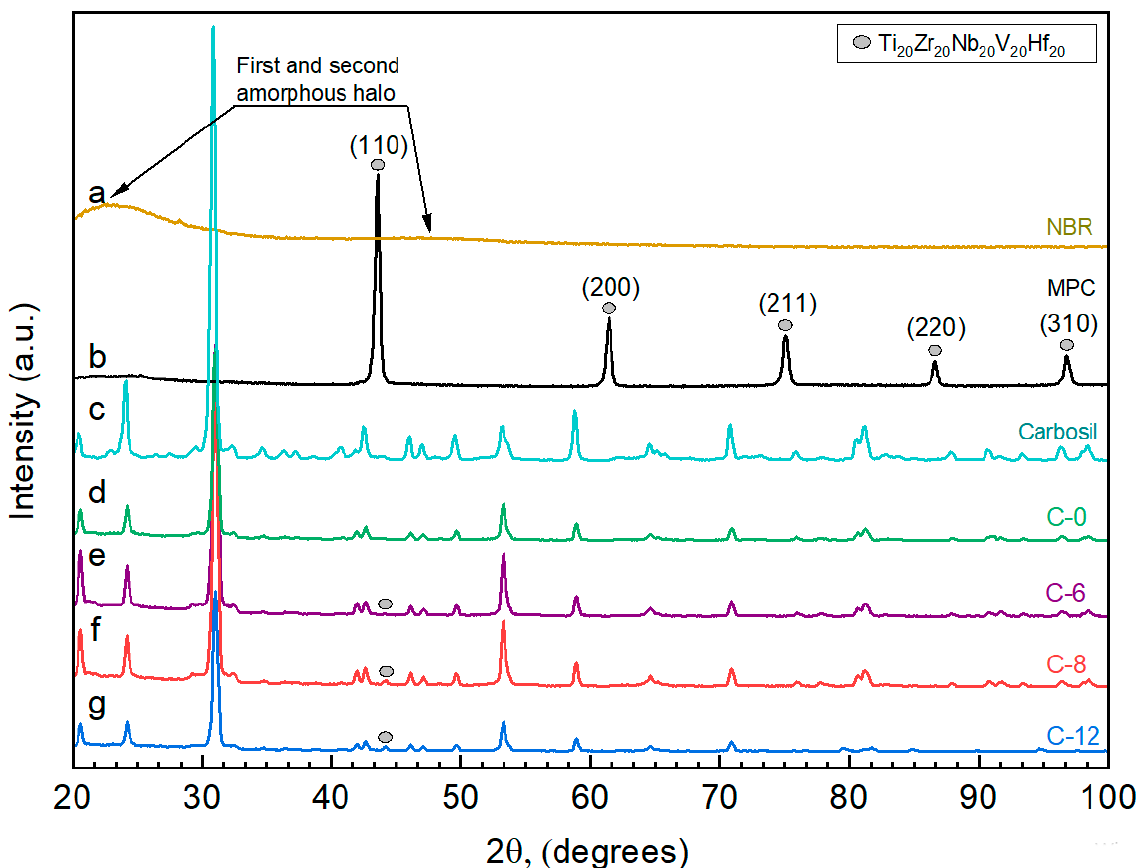
Figure 2. X-ray diffraction patterns of the initial components NBR ( a ), MPC ( b ), Carbosil ( c ) and the obtained composites C-0 ( d ), C-6 ( e ), C-8 ( f ), C-12 ( g ). obtained composites C-0 ( d ), C-6 ( e ), C-8 ( f ), C-12 ( g